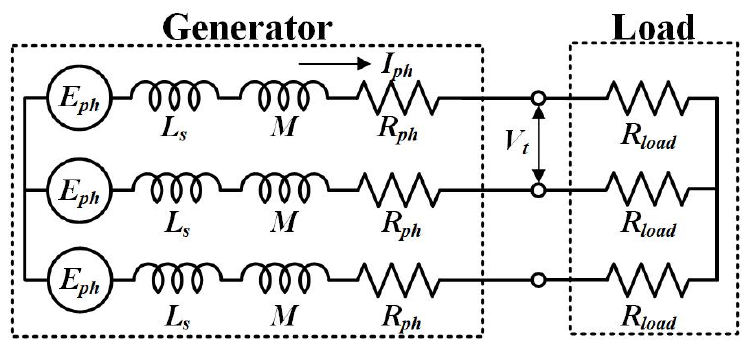
Figure 10. Equivalent circuit of PMSG.